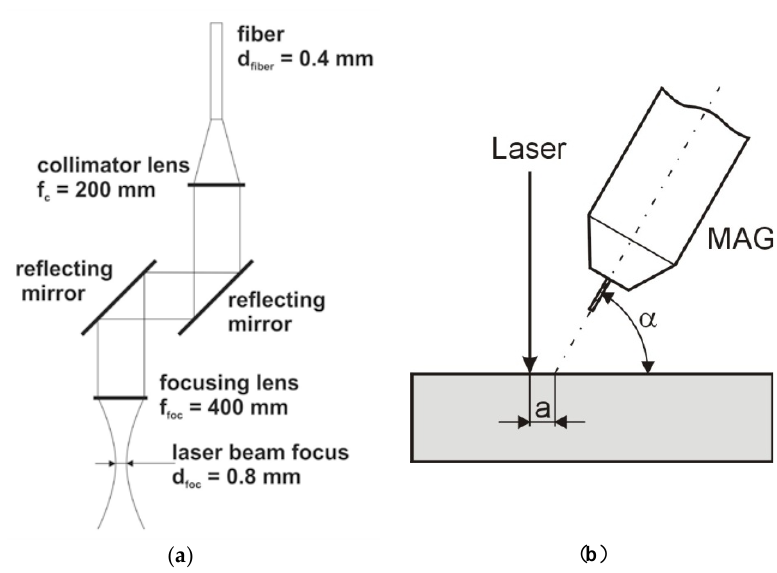
Figure 6. Diagram of the laser optical system and the position of the laser beam and electric arc in the hybrid technology. ( a ) the laser optical system, ( b ) position of the laser beam and electric arc.